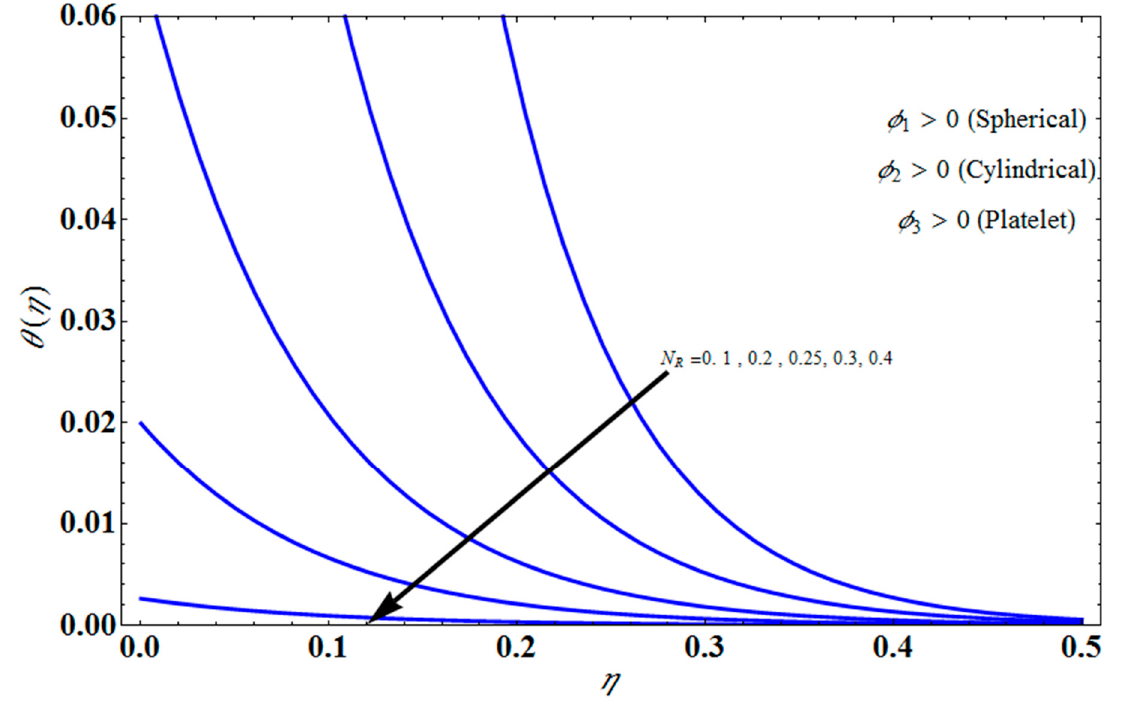
( ) θ η η ( ) θ η η on for several values of on for several values of